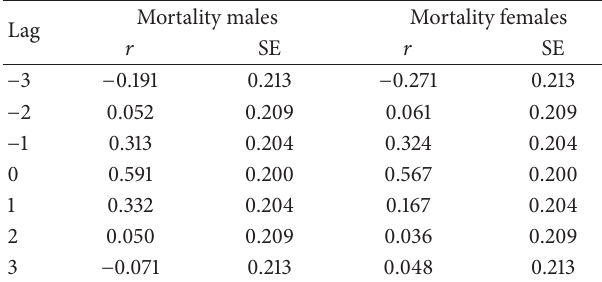
Table 1: The results of cross-correlation analysis between prewhit- ened time-series. Effects of alcohol consumption per capita on HTN mortality rates.